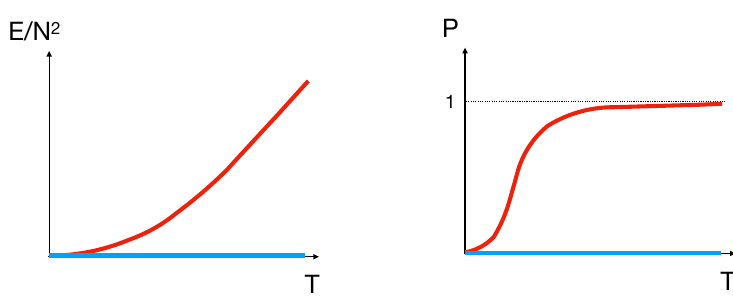
Figure 1. A cartoon picture of the (meta-)stable phases in the BFSS matrix model at finite temperature in the ’t Hooft large- N limit ( λ = g 2 N fixed). Red and blue lines characterize the deconfined and confined phases, respectively. In the past, the existence of the confined phase was not pointed out. Both are minima of the free energy, and the deconfined phase is the global minimum at any temperature. The existence of the confined phase is a natural consequence of the dual M- theory description, hence, the numerical confirmation of the confined phase on the matrix model side would be an interesting clue towards demonstrating the validity of the M-theory